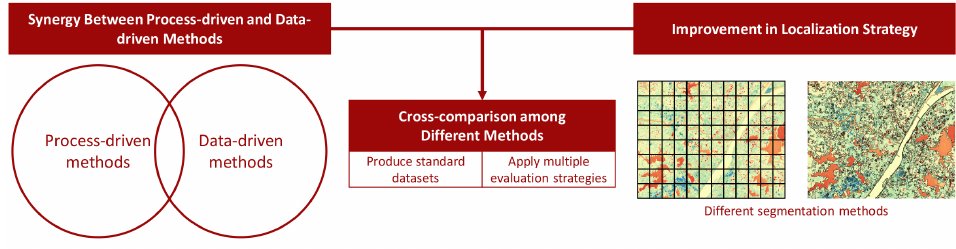
Figure 3. Key future directions for LST resolution